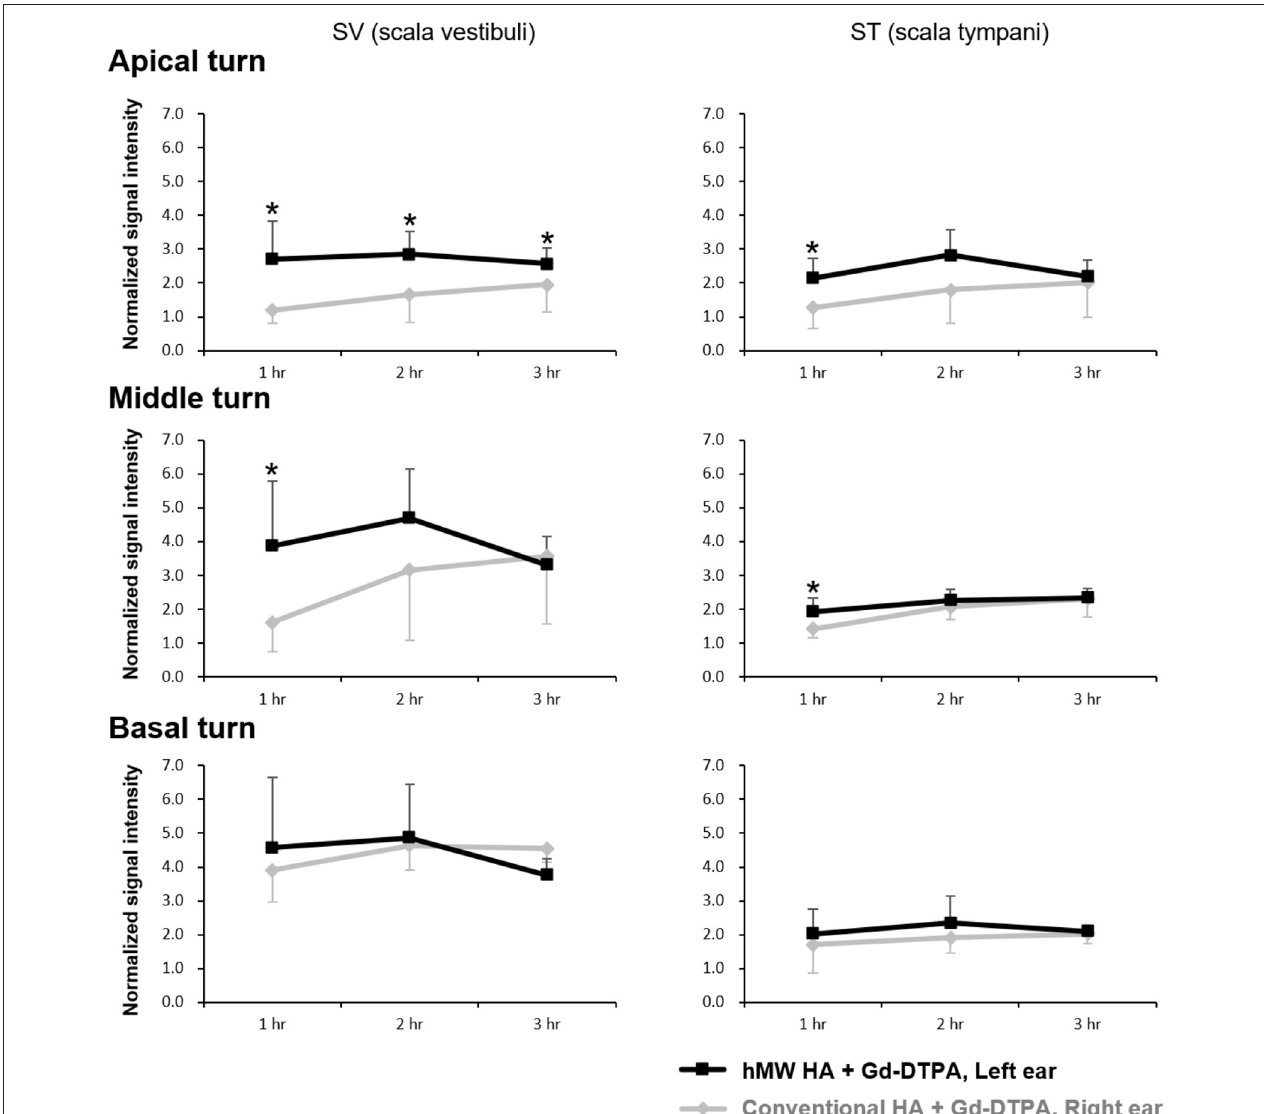
FIGURE 3 | Quantification of short-term normalized signal intensities (SIs) in the scala vestibuli (SV) and scala tympani (ST) after intratympanic (IT) gadolinium (Gd) injection with two different vehicles. The SI was higher when Gd-DTPA was delivered with the high-molecular-weight (hMW) hyaluronic acid (HA) vehicle compared to the conventional HA vehicle. This difference was most significant at 1h after IT Gd injection in the apical and middle turns. The SI in the basal turn was similar between the two vehicles. * p <